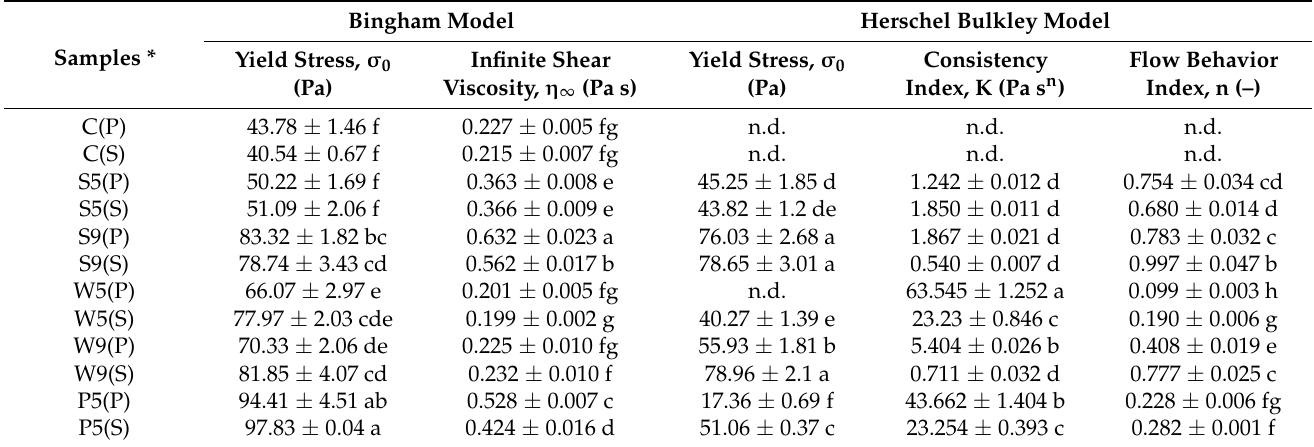
Table 4. The values of rheological models for protein-enriched plant-based pur é